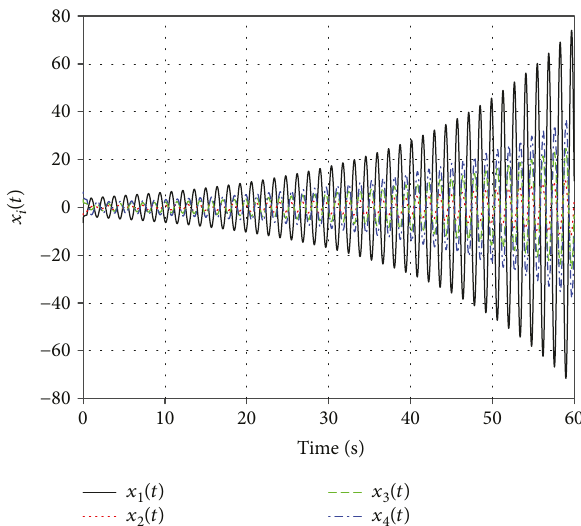
t applying the protocol in (7) under i . 2